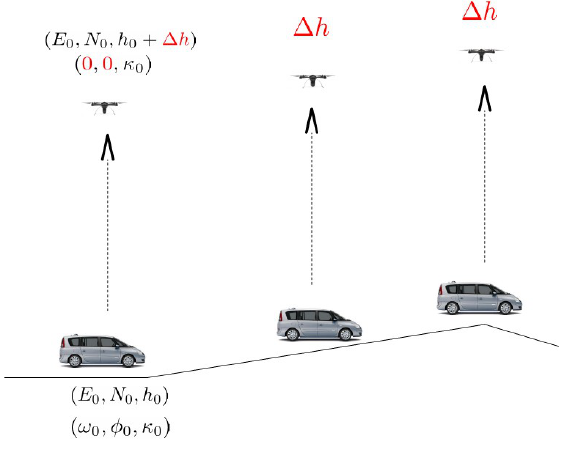
Figure 3. The mapKITE TV-to-UA virtual